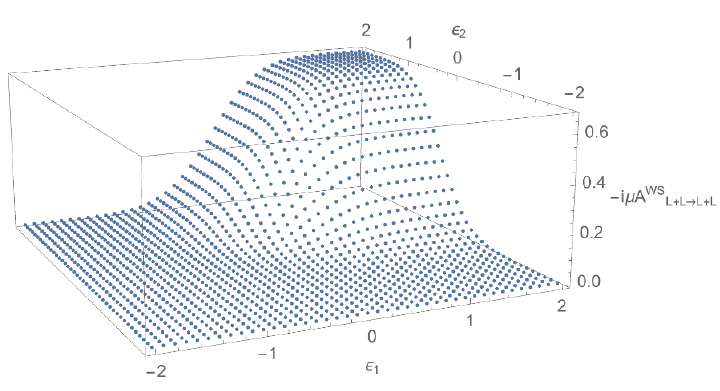
Figure 10 . Long string amplitude A L + L ! L + L as a function of incoming long string renormalized energies (cid:15) 1 ; (cid:15) 2 , evaluated at a (cid:12)xed outgoing long string renormalized energy (cid:15) 3 = 0 : 5.